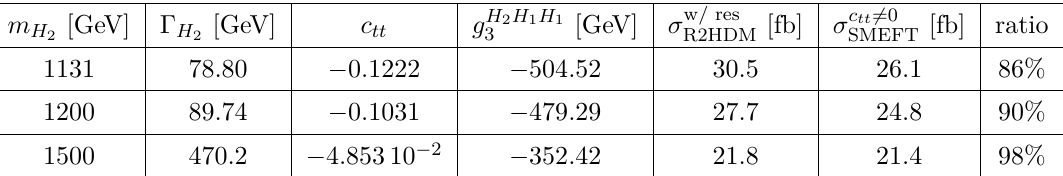
and corresponding Γ 2